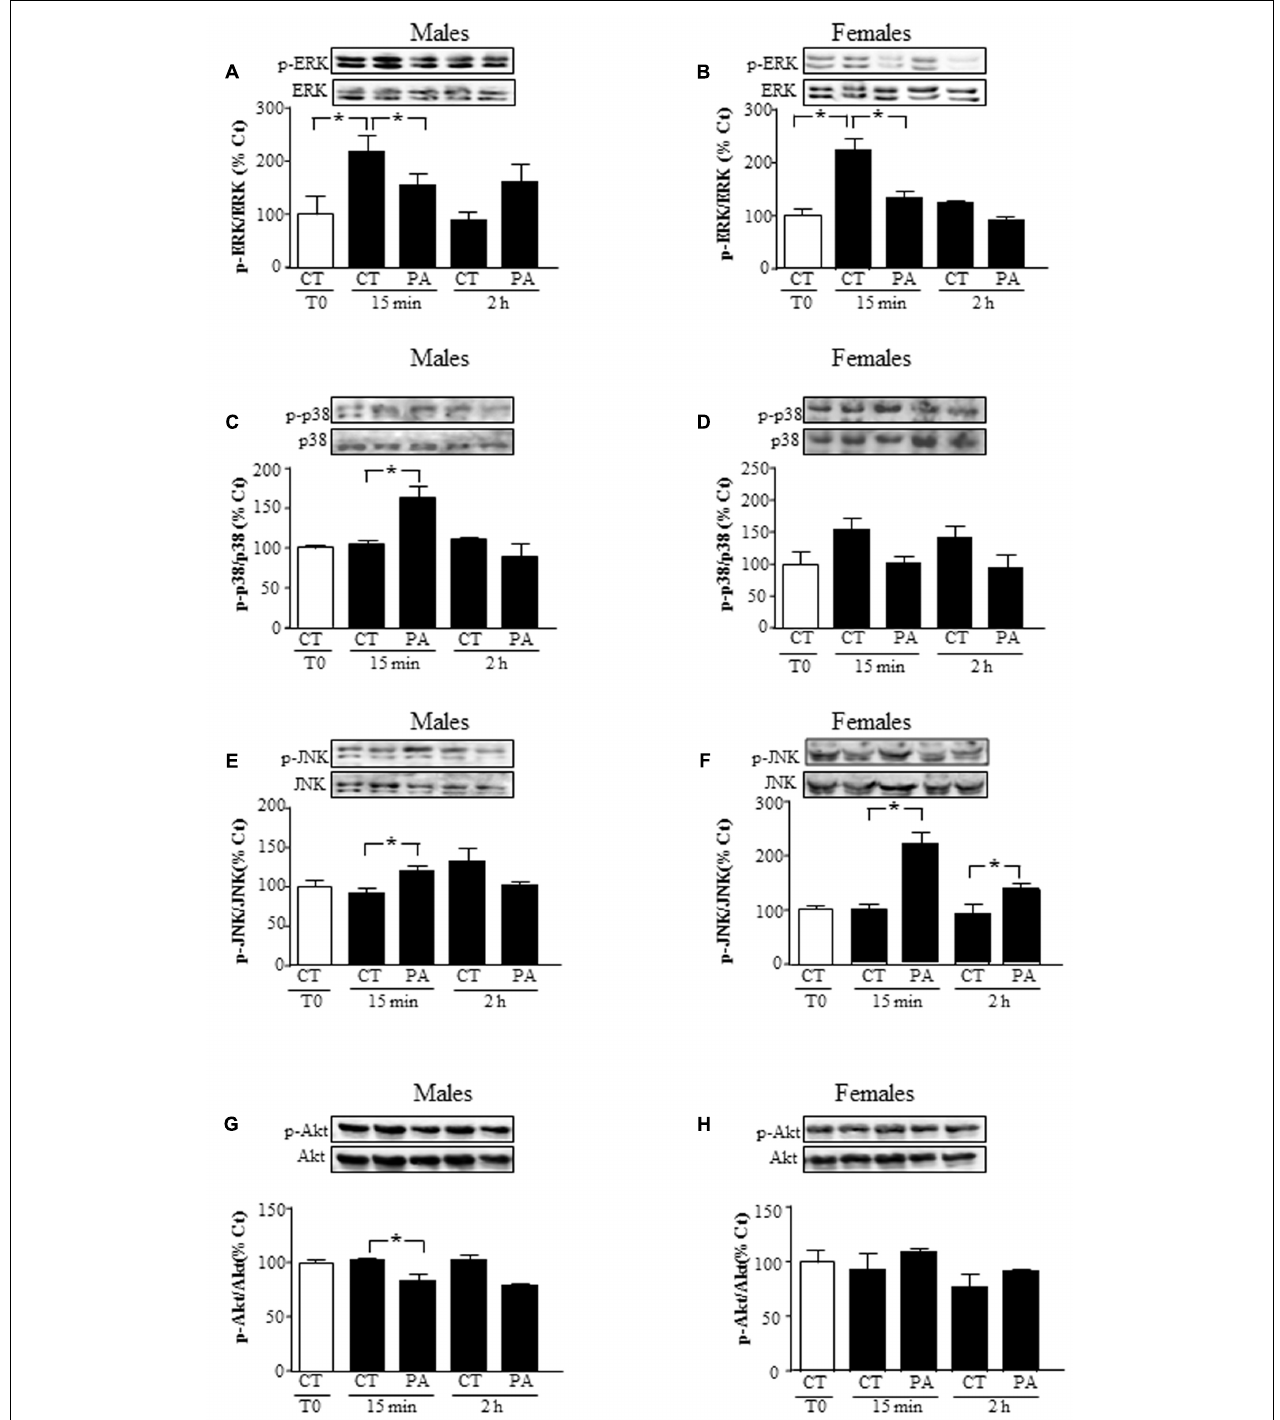
FIGURE 2 | Effects of PA on the activation of mitogen activated protein kinases (MAPKs) and protein kinase B (Akt). Astrocyte cultures were treated with PA (0.5 mM), E2 (10 − 10 M) or the combination of both. Immunoblots were probed with antibodies toward phosphorylated-extracellular signal-regulated kinases (pERKs) and extracellular signal-regulated kinases (ERKs) in male (A) , and female (B) astrocytes; phosphorylated-p38 (p-p38) and p38 in male (C) and female (D) astrocytes; phosphorylated (p)-c-Jun N-terminal kinase (p-JNK) and JNK in astrocyte cultures of males (E) and females (F) and phosphorylated-protein kinase B (p-Akt) and protein kinase B (Akt) in male (G) , and female (H) astrocytes. The average of three independent assays performed in duplicate is shown. Statistical significance: ∗ p < 0.05.